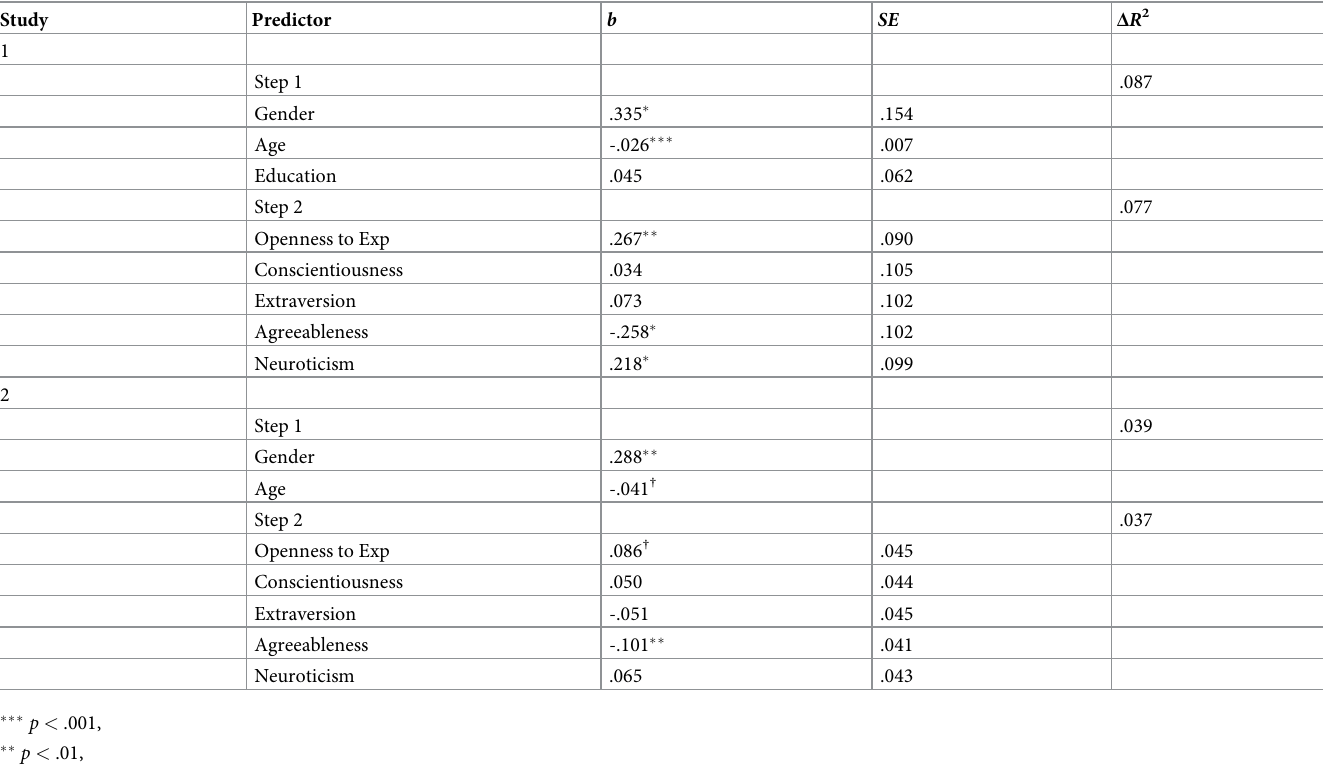
Table 5. Results of hierarchical regression analyses predicting scores on the